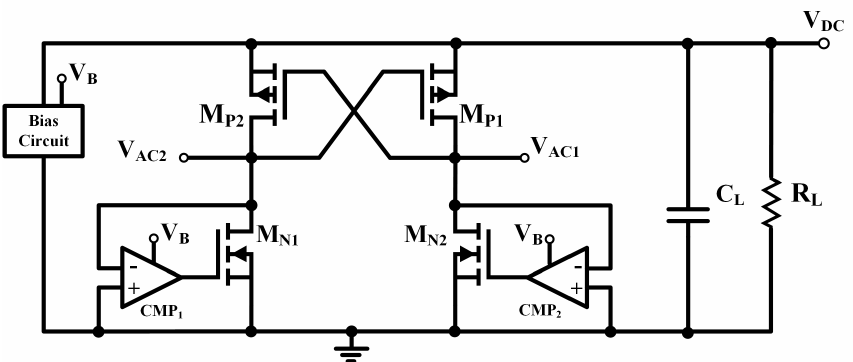
Figure 7. Active full-wave rectifier with NMOS active